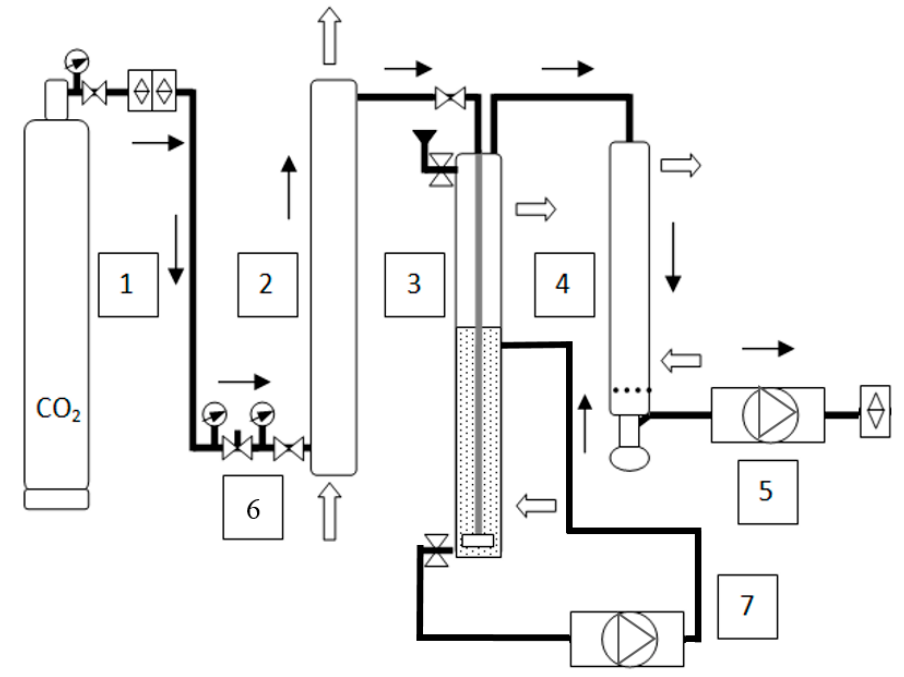
Figure 1. Schematic representation of the vacuum assisted in-situ gas stripping recovery system with the column bioreactor. 1. CO 2 bottle; 2. Gas heater; 3. Column bioreactor; 4. Condenser; 5. Vacuum pump; 6. Gas rotor-flowmeter; 7. Peristaltic pump.